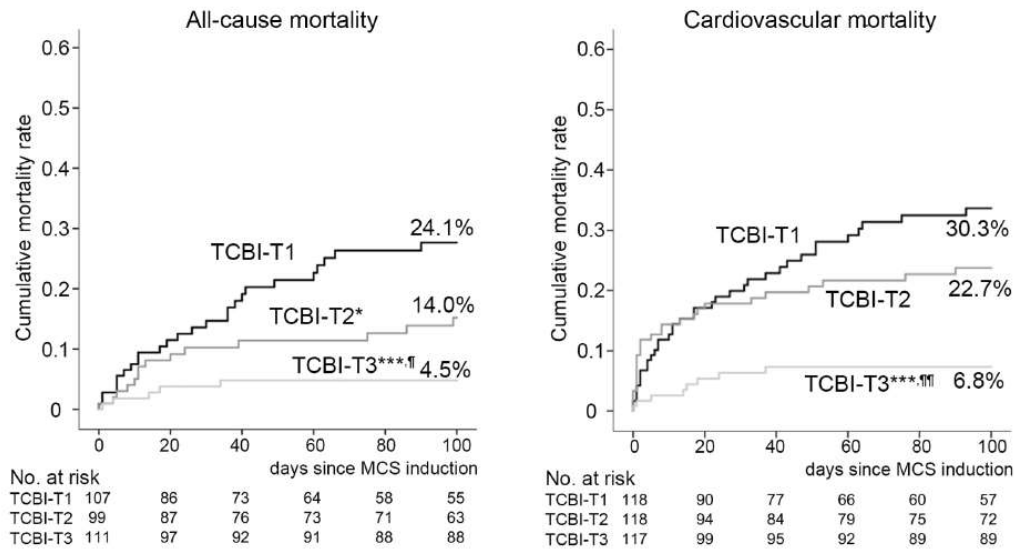
Figure 2. Higher TCBI was associated with reduced risk of all-cause and cardiovascular mortalities. Kaplan–Meier analysis and log-rank comparisons to assess cumulative incidence rates of both all- cause (left panel) and cardiovascular (right panel) mortality in accordance with tertile of TCBI. * <0.05, ** <0.01, *** <0.001 in log-rank comparison vs. TCBI-T1 and ¶ <0.05, ¶¶ <0.01, ¶¶¶ <0.001 vs. TCBI-2.